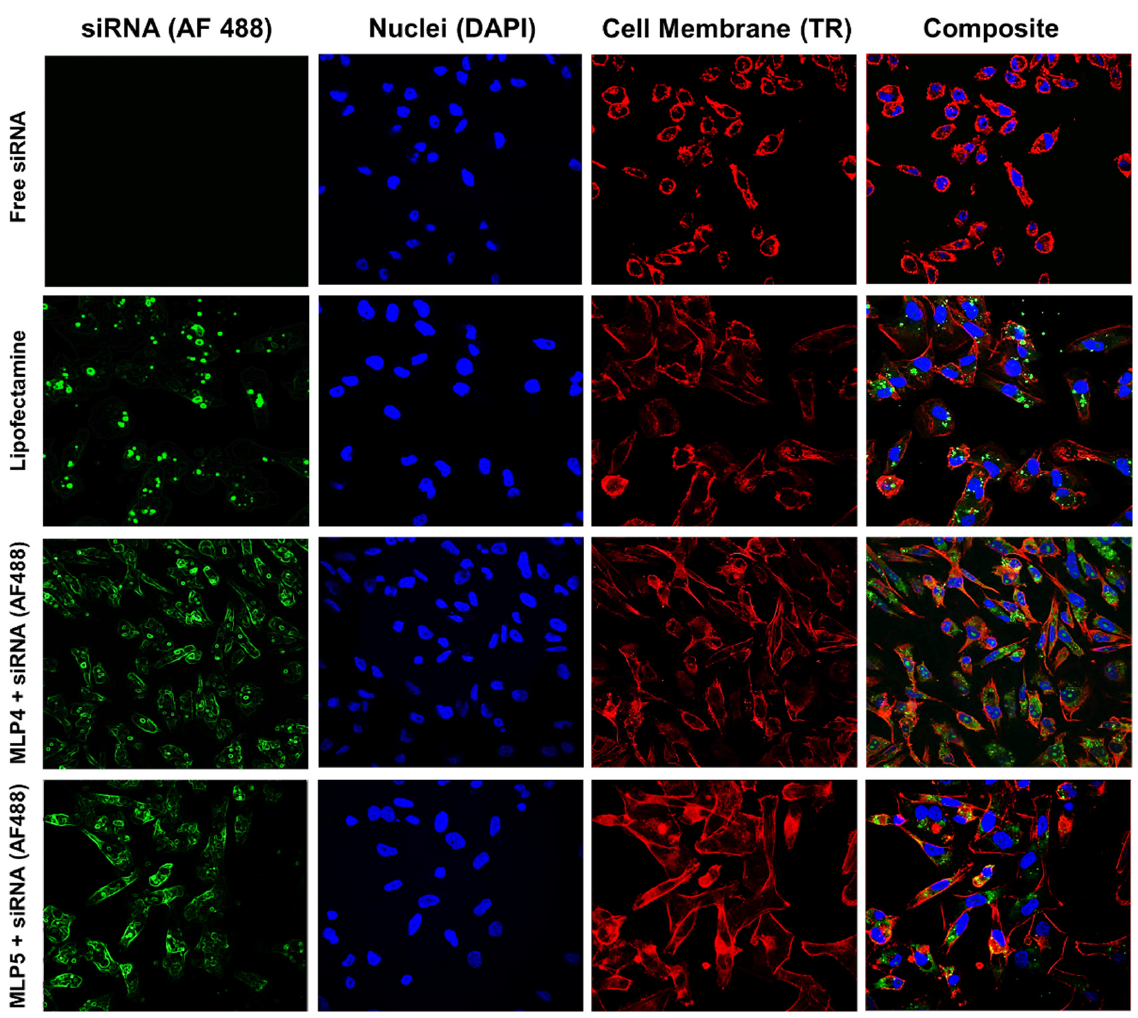
Figure 8. Representative confocal images of the MDA-MB-231 cells following treatment with Alexa Fluor 488-labeled siRNA-peptide (MLP4 or MLP5) complexes. Free siRNA-treated cells were used as a negative control, while Lipofectamine-siRNA complex served as a positive control.